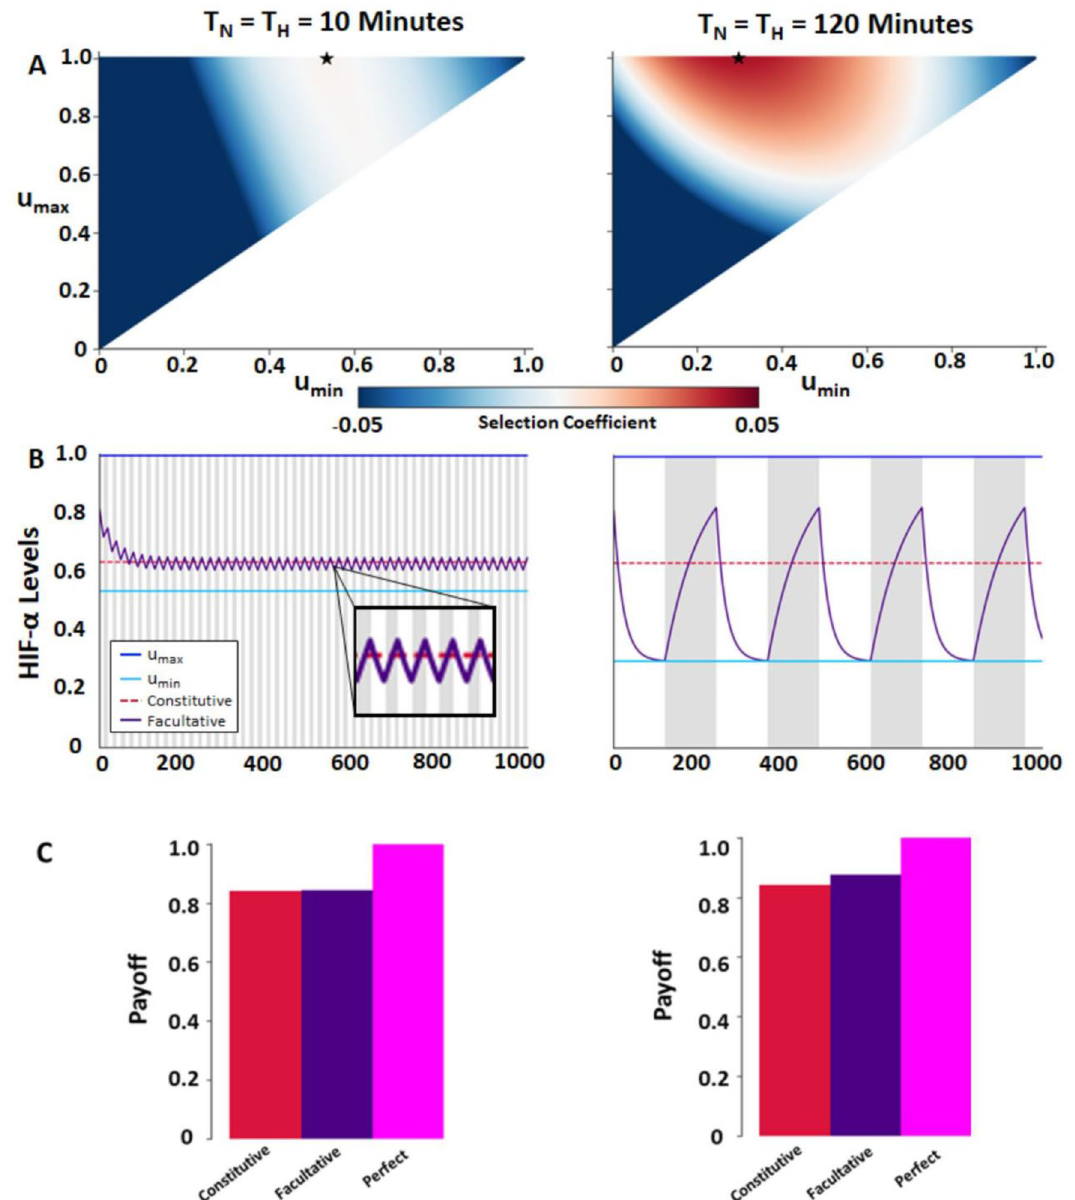
Figure 2. Comparison environments with fixed intervals of short (10 min) and long (120 min) periods of cycling hypoxia. ( A ) Heatmap of the selection coefficients for the facultative strategy for all u min and u max combinations. Each star denotes the u min and u max combination that maximizes payoffs for the facultative strategy for each fixed interval time. ( B ) HIF-α ( u ) levels over time using the optimal facultative strategy. The unshaded areas represent periods of full oxygenation while the shaded grey areas represent periods of hypoxia. ( C ) Payoffs for separate strategies of HIF-α expression normalized to the perfect strategy. Parameters are given in Table